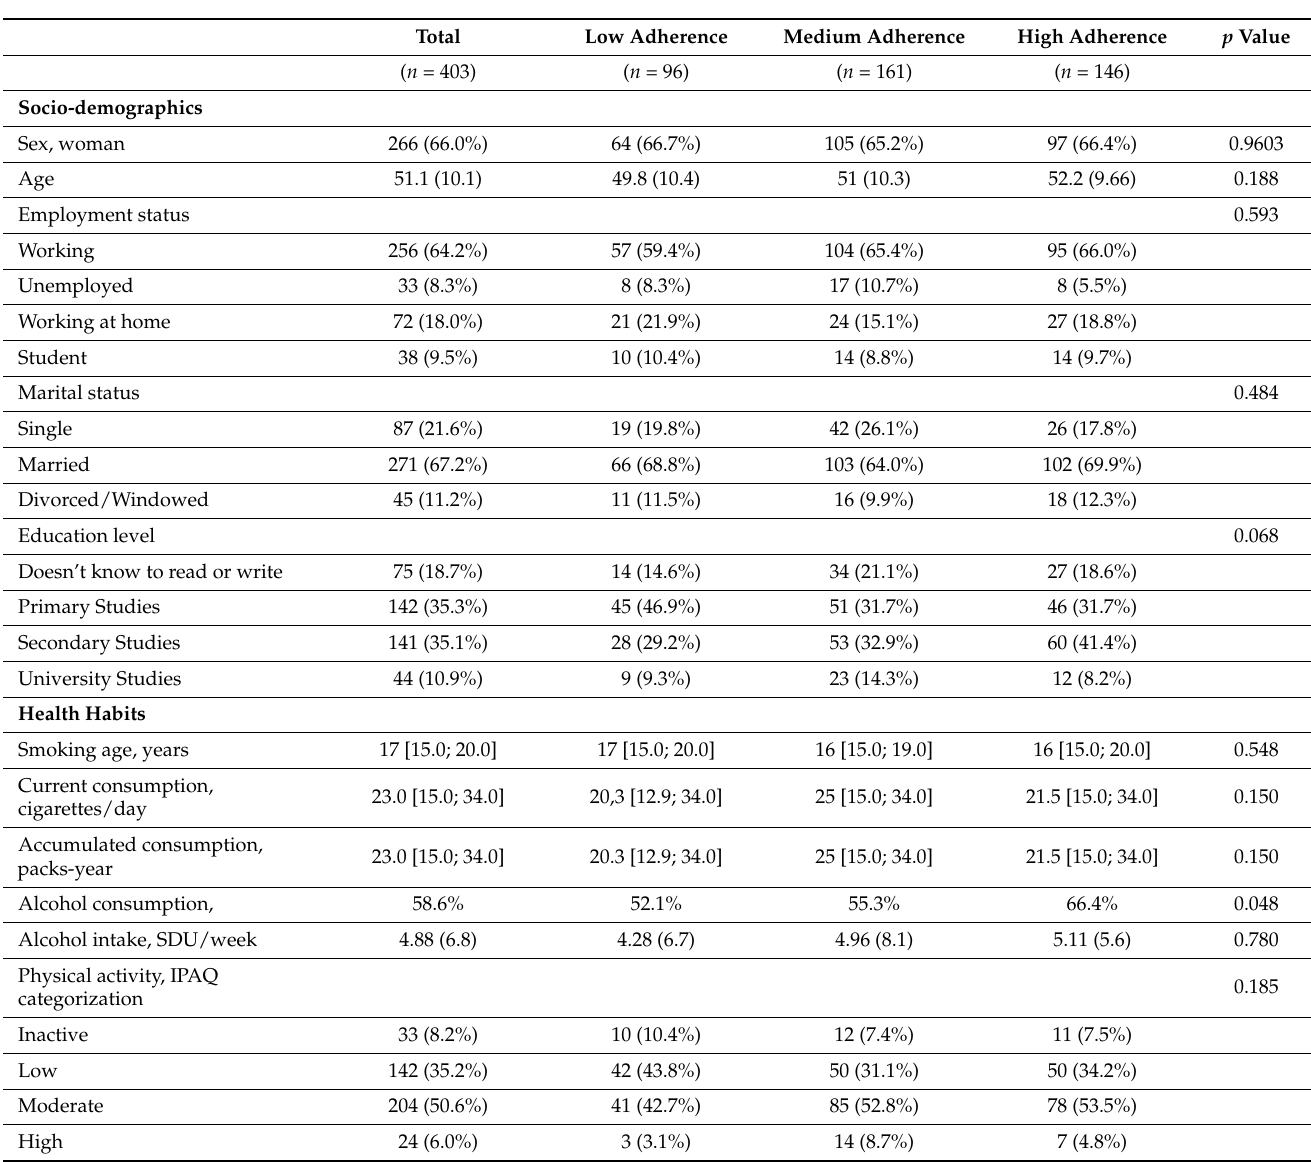
Table 1. Sociodemographic, habits and exploratory descriptive variables according to adherence to Mediterranean Diet group (*). Total Low Adherence Medium Adherence High Adherence p